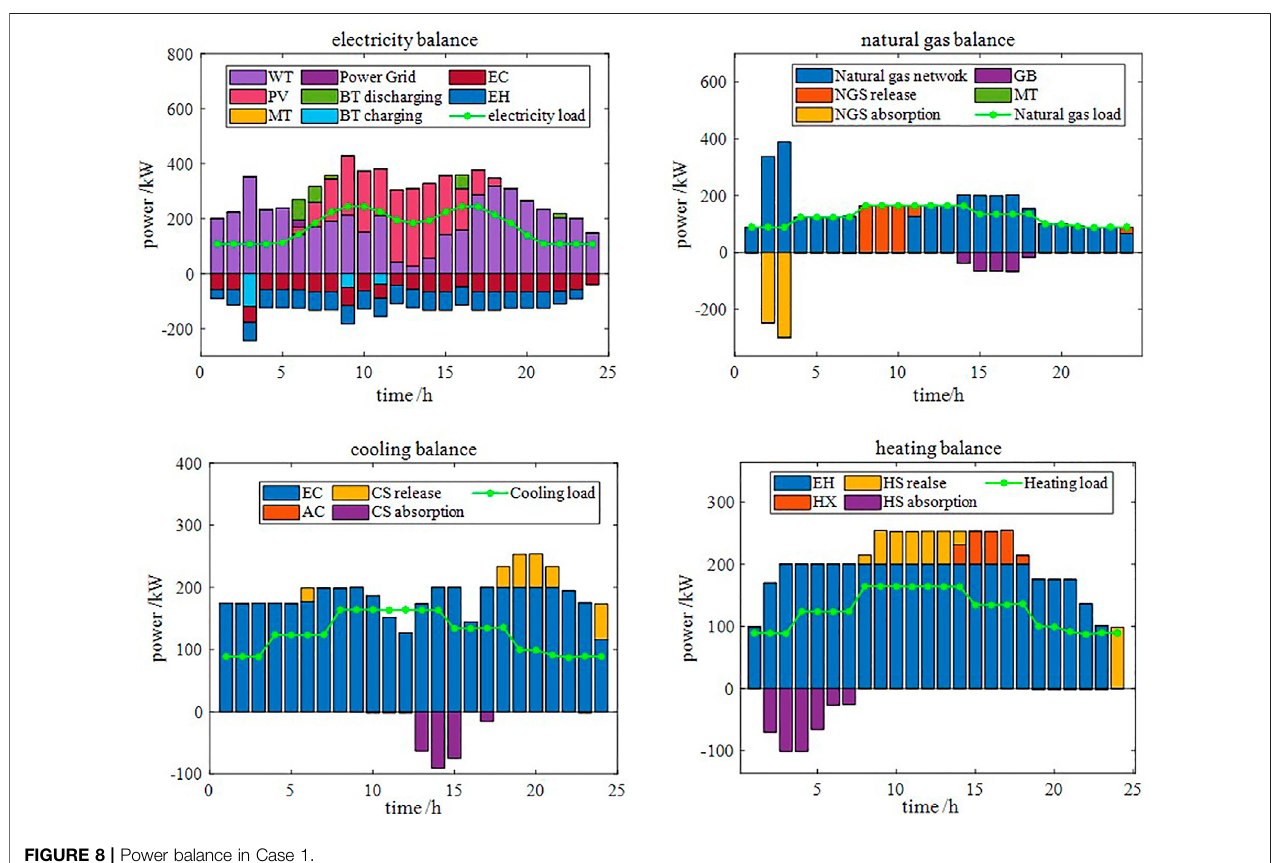
FIGURE 8 | Power balance in Case